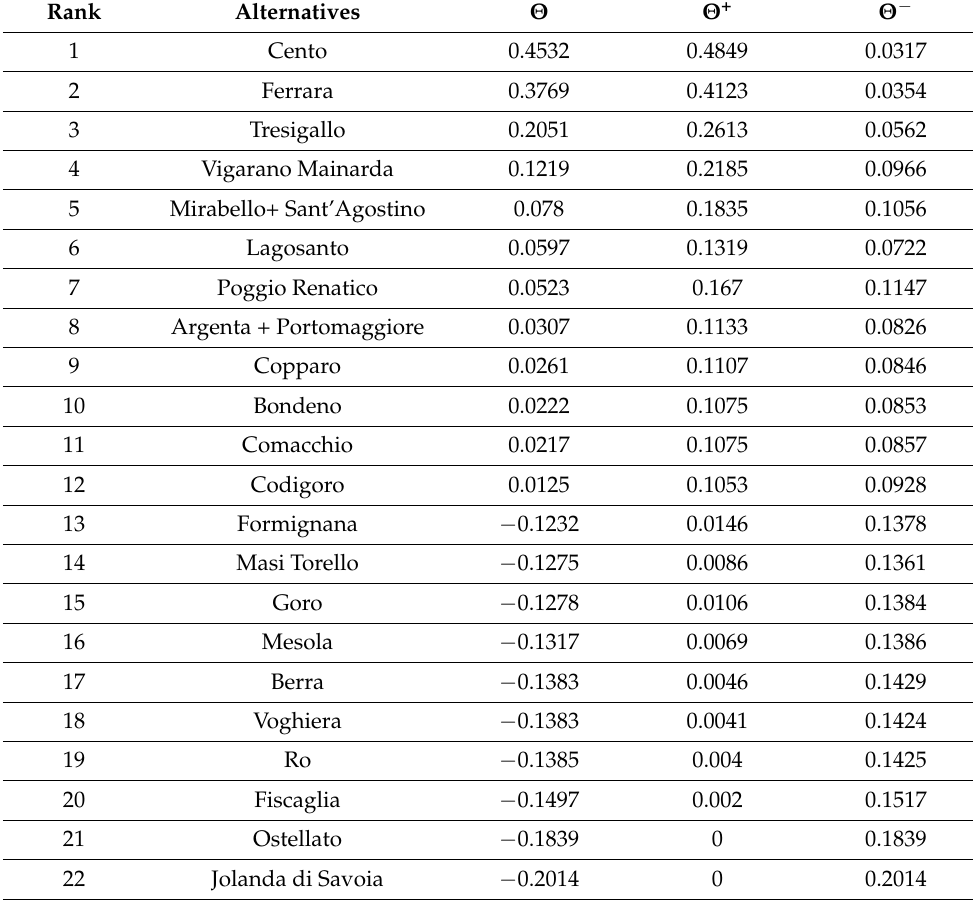
Table 6. Ranking of alternatives for the linear preference function and std-mean